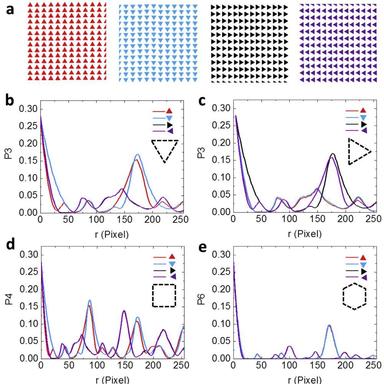
(a) Model microstructures composed of congruent equilateral triangle particles with different orientations arranged on a square lattice. The resolution of the images is 1048 by 1048 pixels. (b) Directional 3-point polytope functions P3 for the model microstructures associated with vertically oriented triangular sampling templates. (c) Directional 3-point polytope functions P3 for the model microstructures associated with horizontally oriented triangular sampling templates. (d) 4-point polytope functions P4